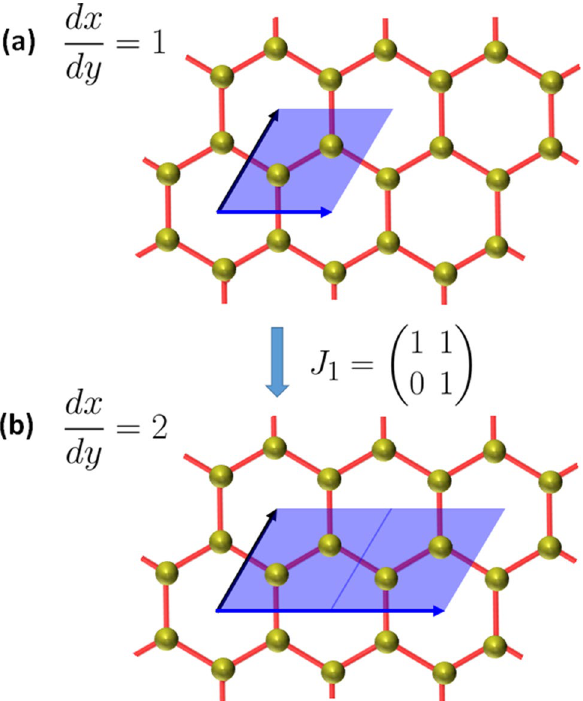
Figure 4. The honeycomb lattice of cations depicting the action of the J 1 generator of SL 2 ( Z ) on the primitive vectors. ( a ) The primitive vectors dx and dy of the primitive cell of the honeycomb lattice, where dx / dy the number of pairs of cations enclosed within the primitive cell; ( b ) J 1 transformation corresponding to the re-scaling of the dx primitive vector and hence an expansion of the unit cell, dx / dy